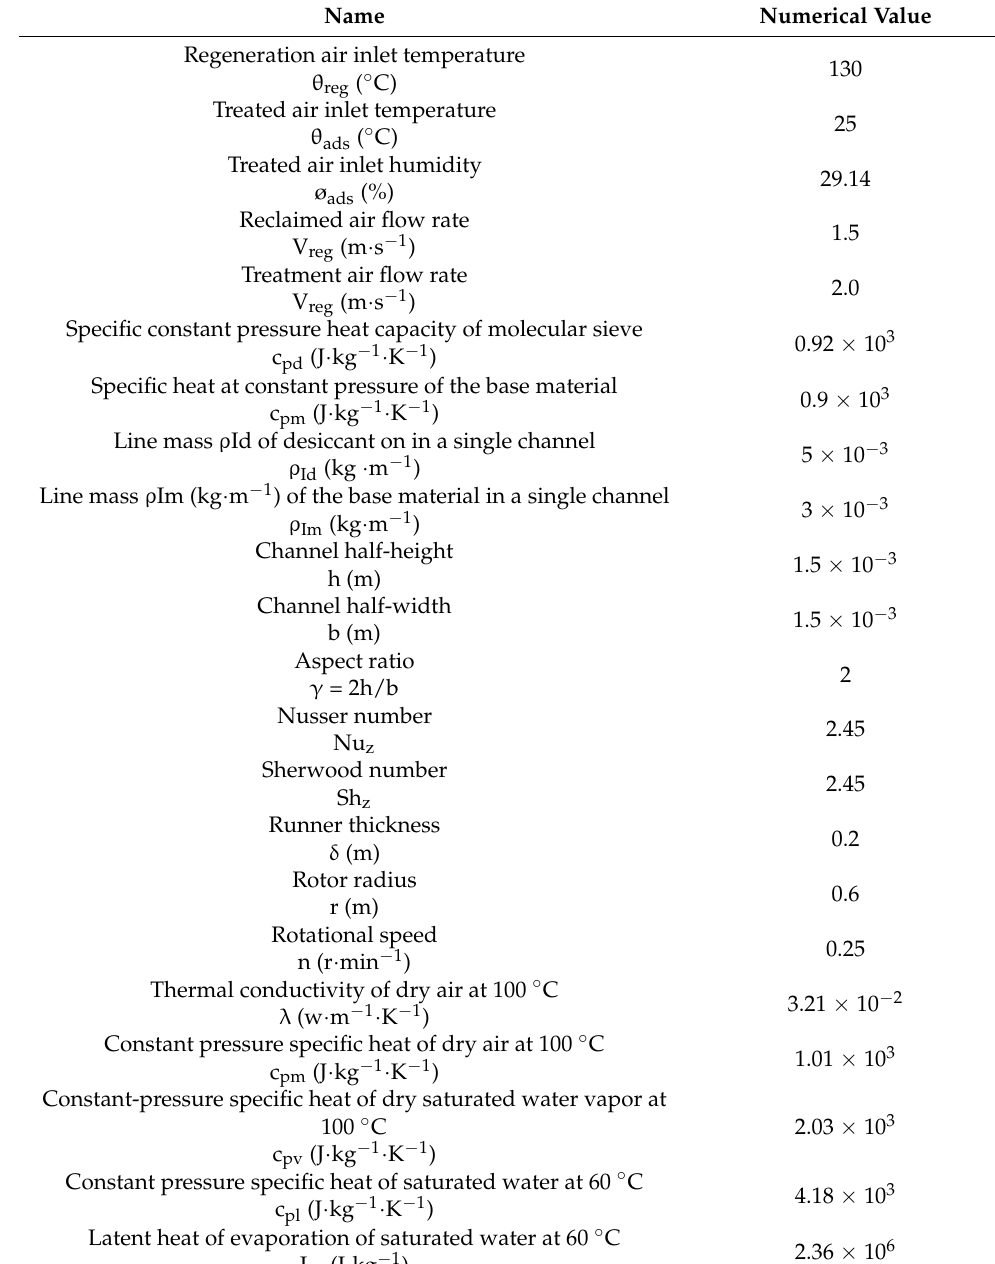
Table 1. Initial parameters for the calculation of the mathematical model of heat and mass transfer of the